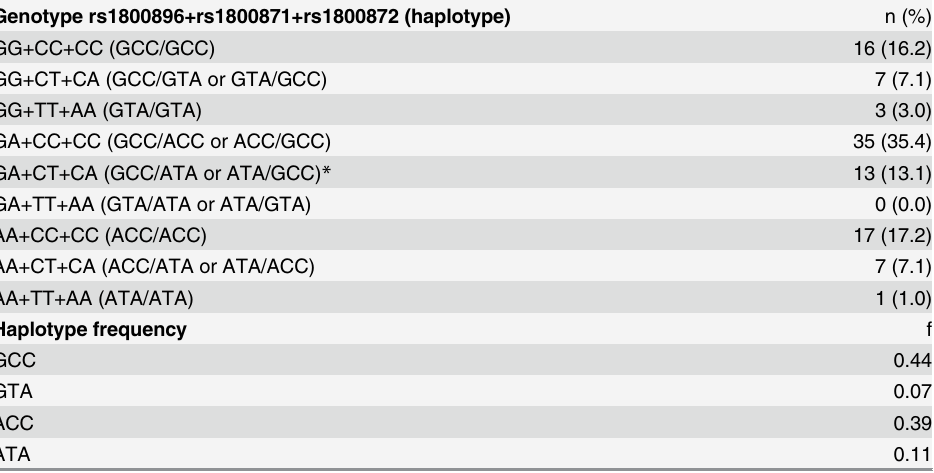
* GTA/ACC or ACC/GTA not present as estimated from the study population frequencies .